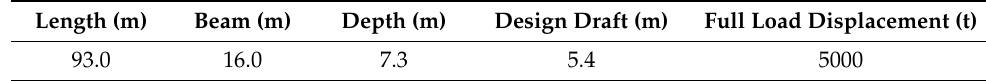
Table 2. The principle dimensions of the supply ship.